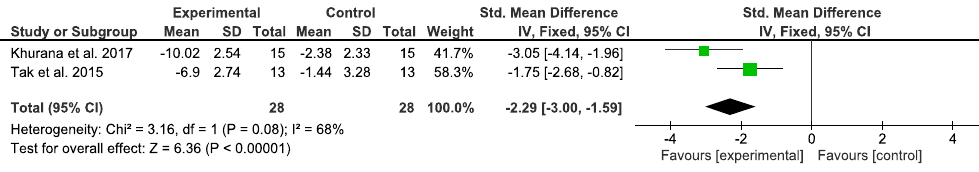
Figure 5. Forest plot for balance measured by the t-shirt test. Green block indicates the weight assigned to the study and the horizontal line depicts the confidence interval. Black rhombus shows the overall result.